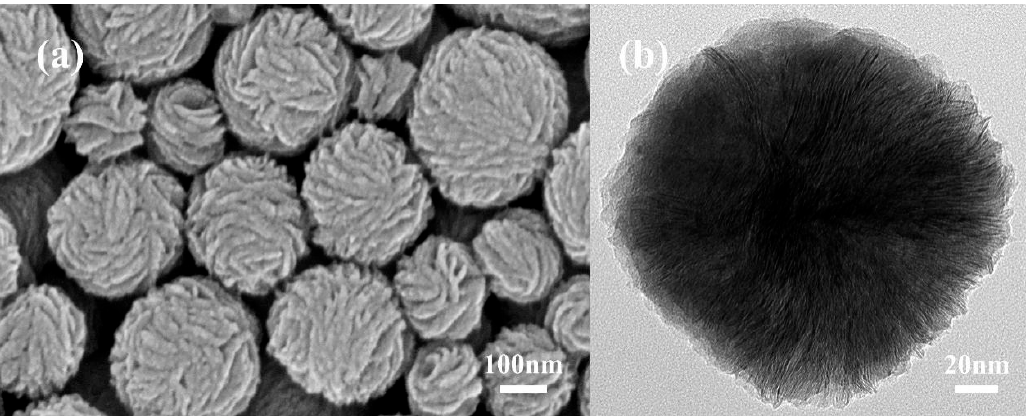
Figure 2. Morphologic characterizations of MoS 2 microspheres prepared by the poly (N-vinyl-2- pyrrolidone) (PVP) micelle-assisted hydrothermal method. ( a ) FESEM image; ( b ) low-resolution TEM image.